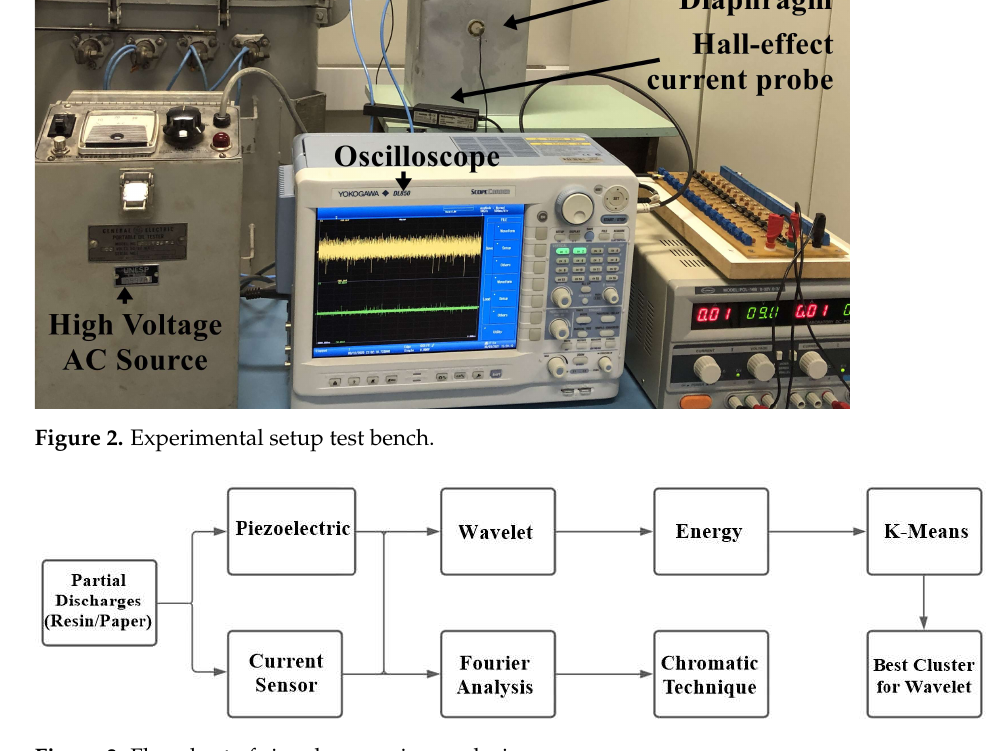
Figure 3. Flowchart of signal processing